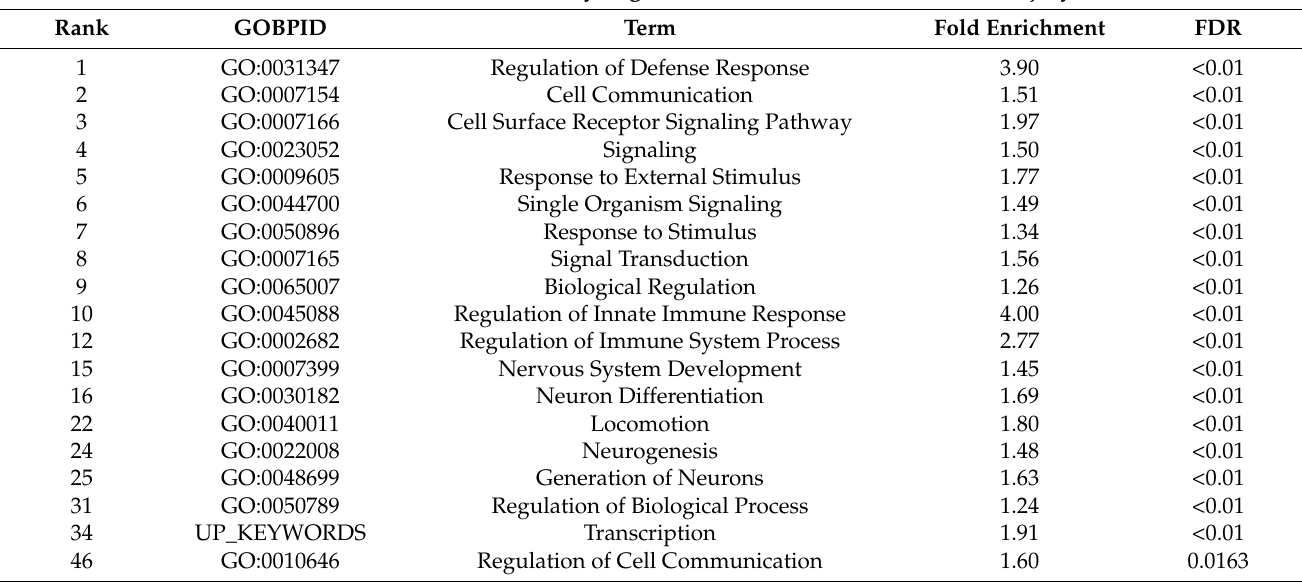
Table 2. Gene ontology terms significantly (FDR < 0.05) changed in response to traumatic brain injury in tau -KO male flies. GO terms were sorted based on FDR and ranked accordingly. Tables show selected GO terms changed in males after injury. GOBPID is the ID of the biological process in GO